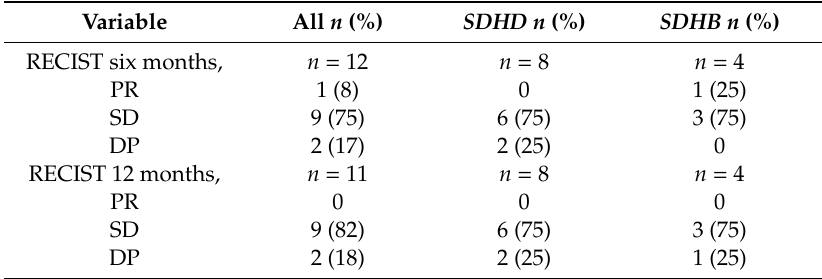
Table 6. Distribution of ORR based on RECIST 1.0-radiological responses for the overall group and for the subgroups of patients with PGL1 (SDHD) or PGL4 (SDHB) NENs. Variable All n